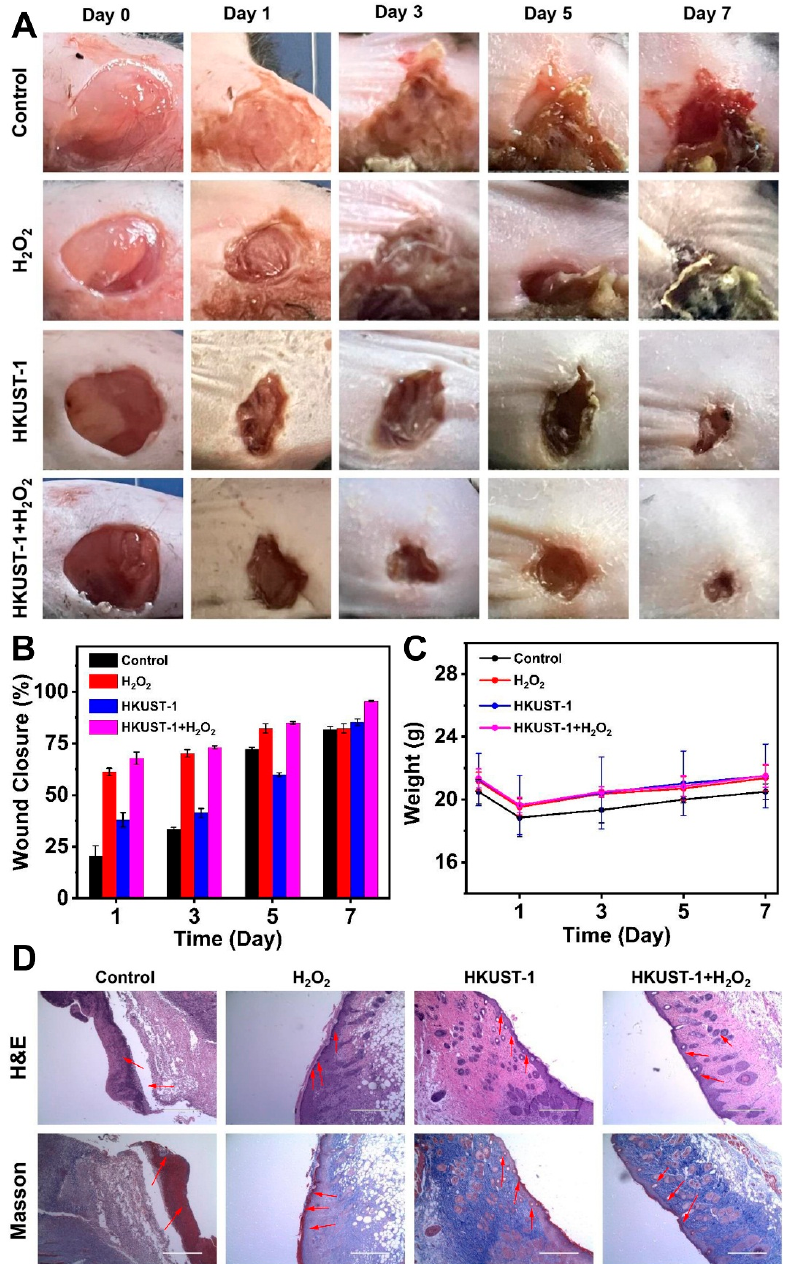
Figure 4. ( A ) Digital photos of MRSA-infected wounds on mice with therapy at different times. ( B ) Relative wound closure size of mice after different therapies. ( C ) Body weight of mice treated with different therapies for 0–7 days. ( D ) Corresponding H&E and Masson staining of skin tissue from mice with different therapies at day 7. The red arrow indicates the edge of the skin wound. Scale bar = 400 μ m.